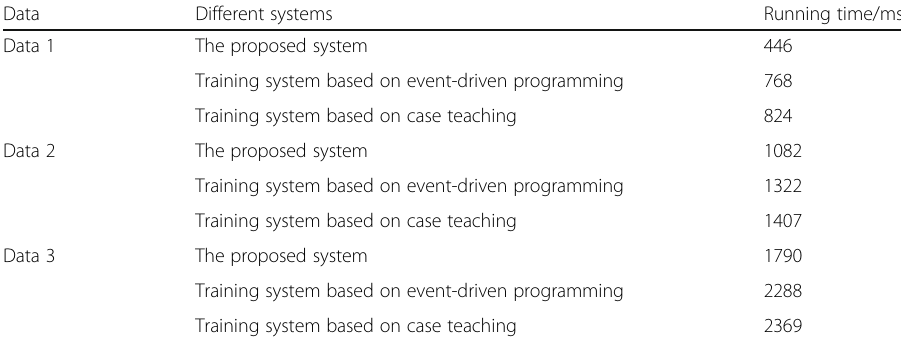
Table 3 Comparison of acceleration ratio performance of different systems